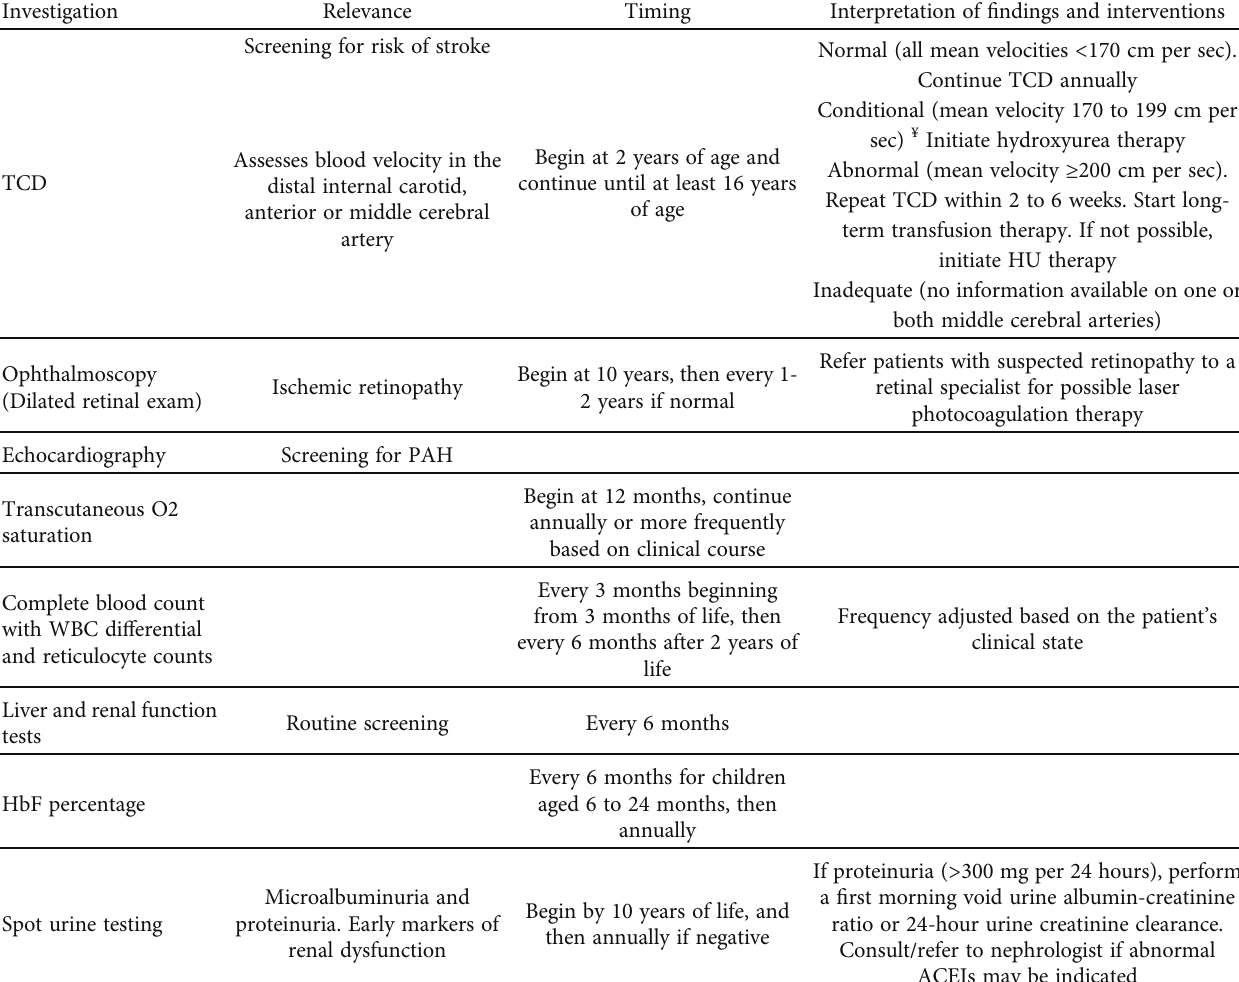
Table 3: Screening/health monitoring of children and adolescents with sickle cell